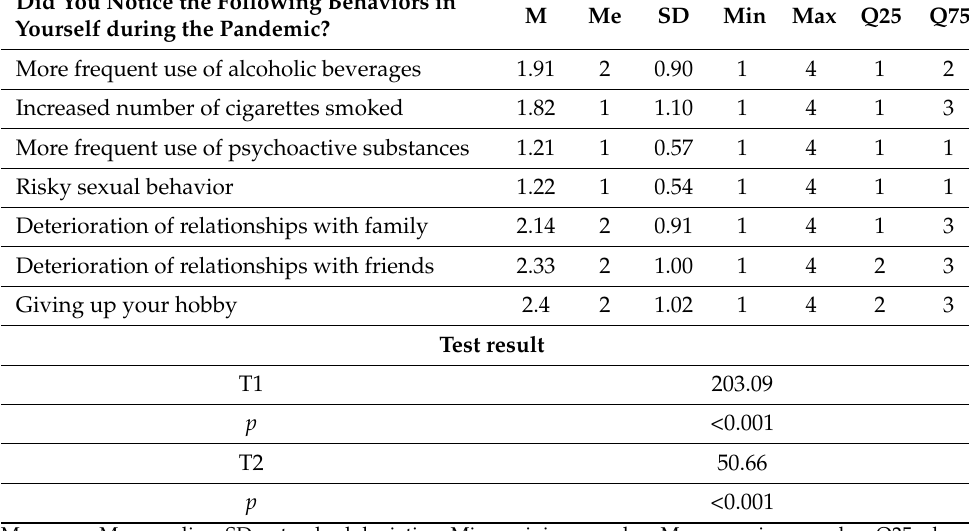
Table 5. Harmful